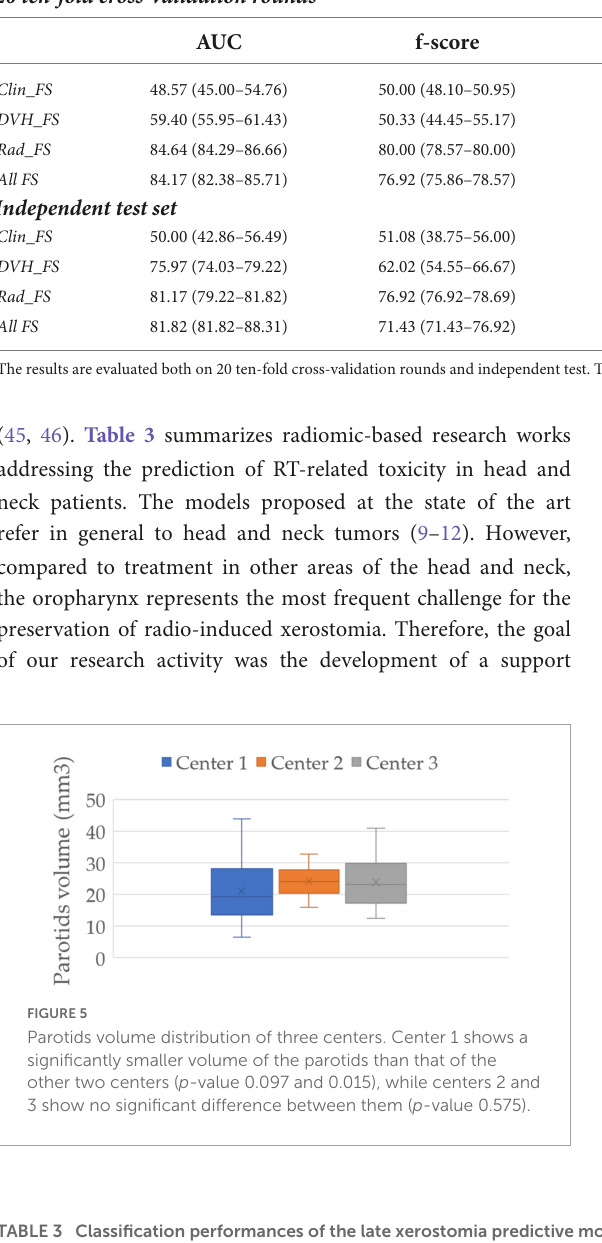
TABLE 2 Classification performances of the late xerostomia predictive models in terms of median percentage and interquartile range (1st–3rd quartiles) AUC, accuracy, sensitivity, and specificity evaluated on real parotid counters. 20 ten-fold cross-validation